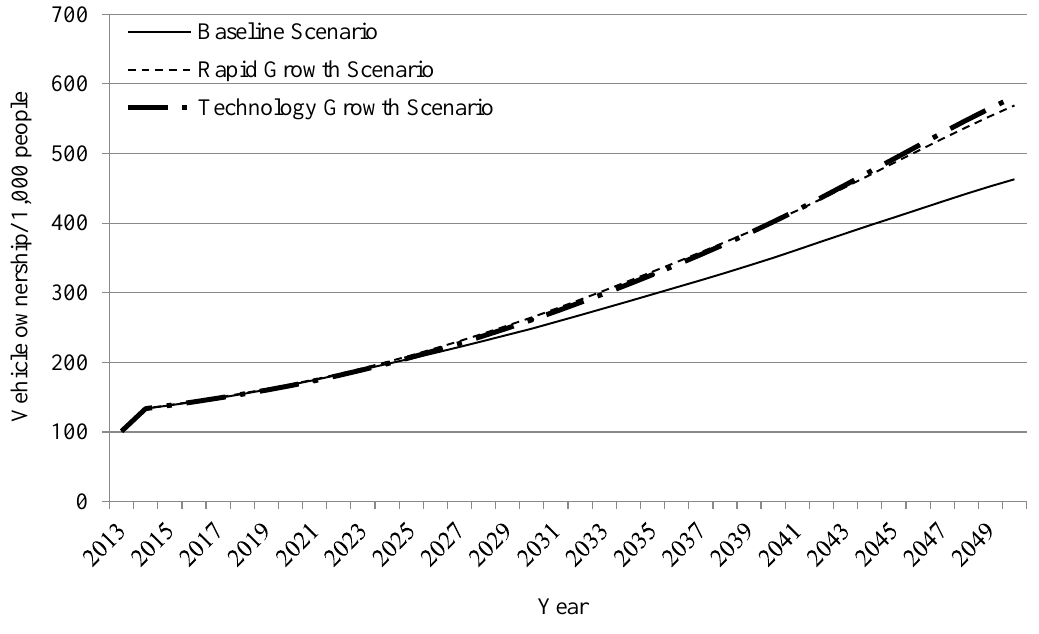
Figure 13. Sensitivity analysis under different GDP growth paths: vehicle stocks.